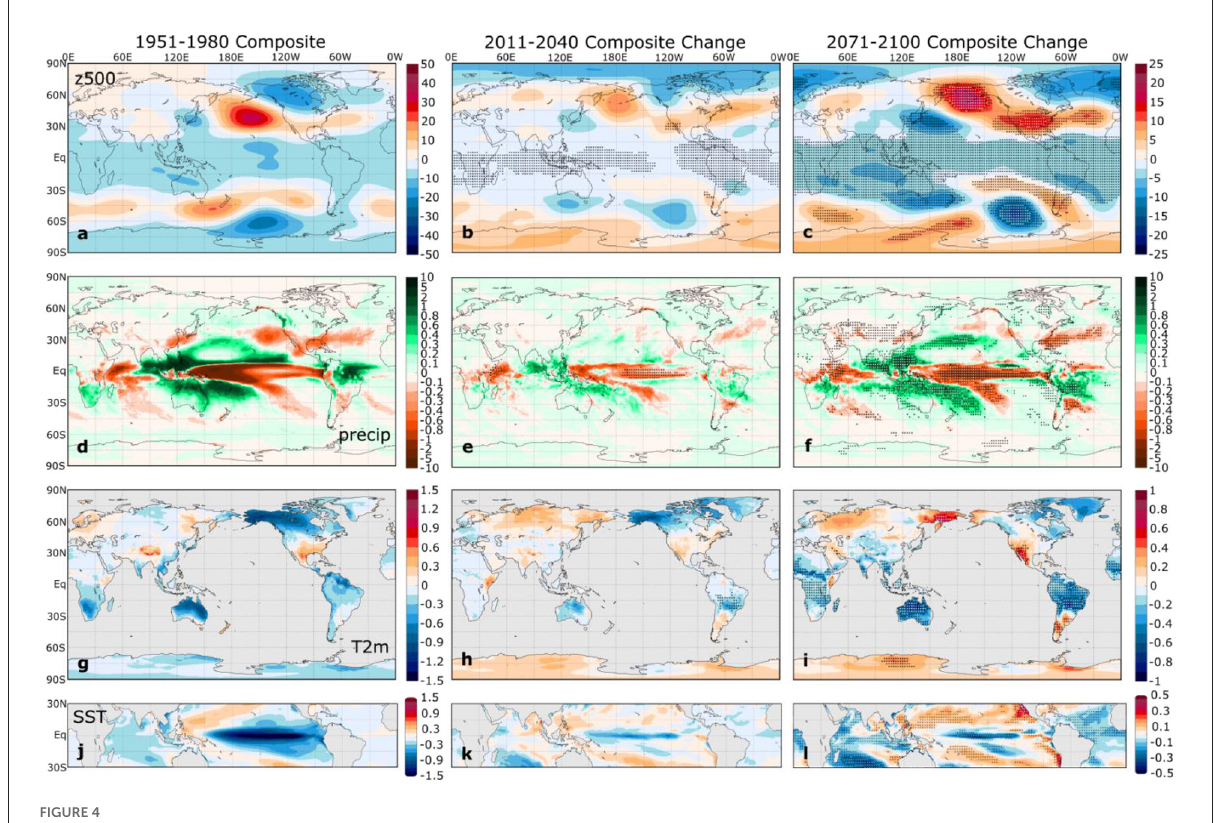
FIGURE4 As in Figure 3 but for La